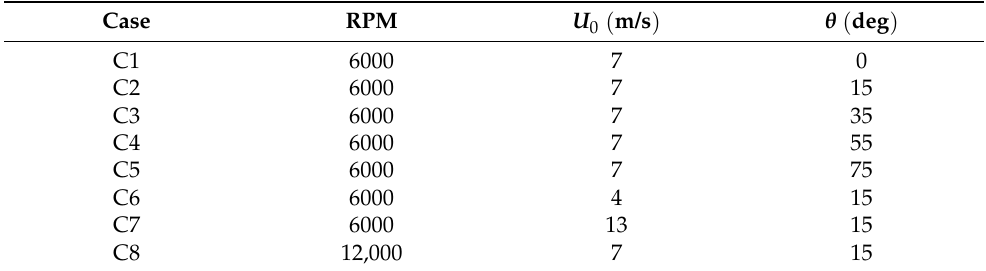
Table 2. Test matrix.